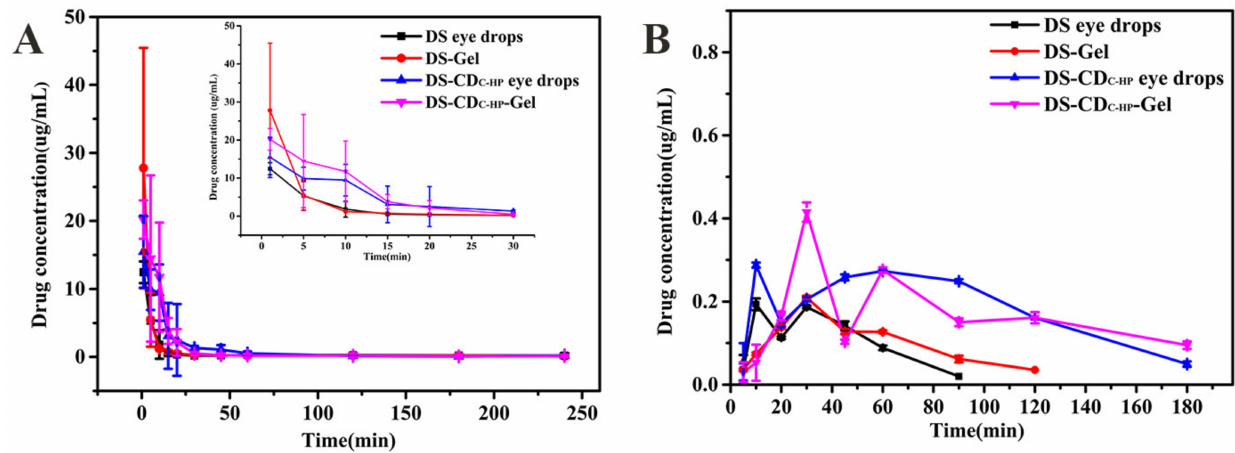
Figure 7. DS concentration vs. time profiles for the DS eye drops, DS-Gel, DS-CD C-HP eye drops and DS-CD C-HP -Gel in lacrimal fluid ( A ) and the rabbit aqueous humor ( B ). Each value is the mean ± SD of three